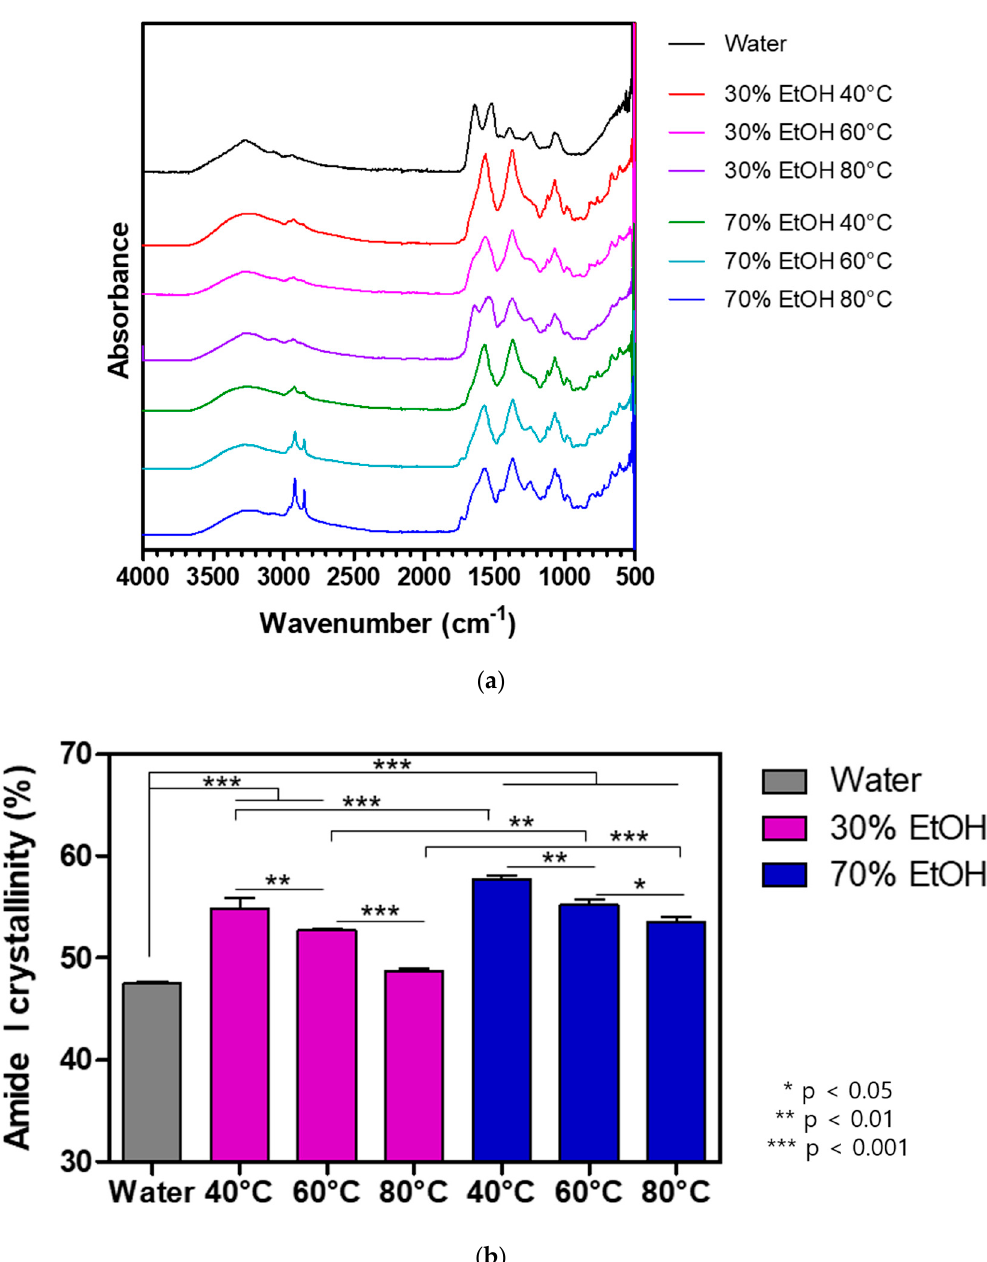
Figure 4. Effects of extraction conditions on the chemical structure of cocoon extracts. ( a ) FTIR spectra and ( b ) amide I crystallinity index of various cocoon extracts. A cocoon extract prepared using the hot water extraction system was considered as a control. * p < 0.05, ** p < 0.01,*** p < 0.005.